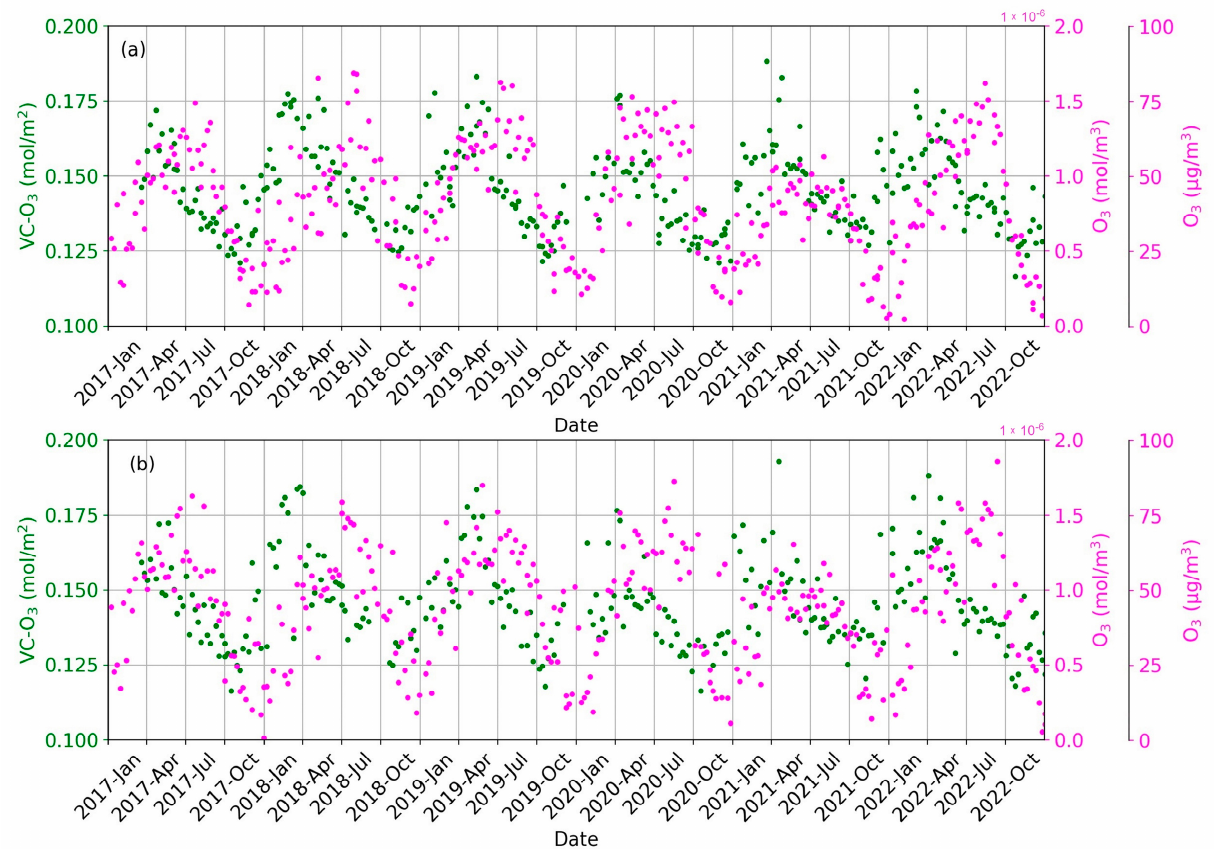
Figure 8. Weekly average time series of VC-O 3 and in situ O 3 concentration for ( a ) weekdays and ( b ) weekends. VC-O 3 is measured at Sapienza (SAP) from Pandora. In situ O 3 concentration is measured at the Villa Ada (VA) station.